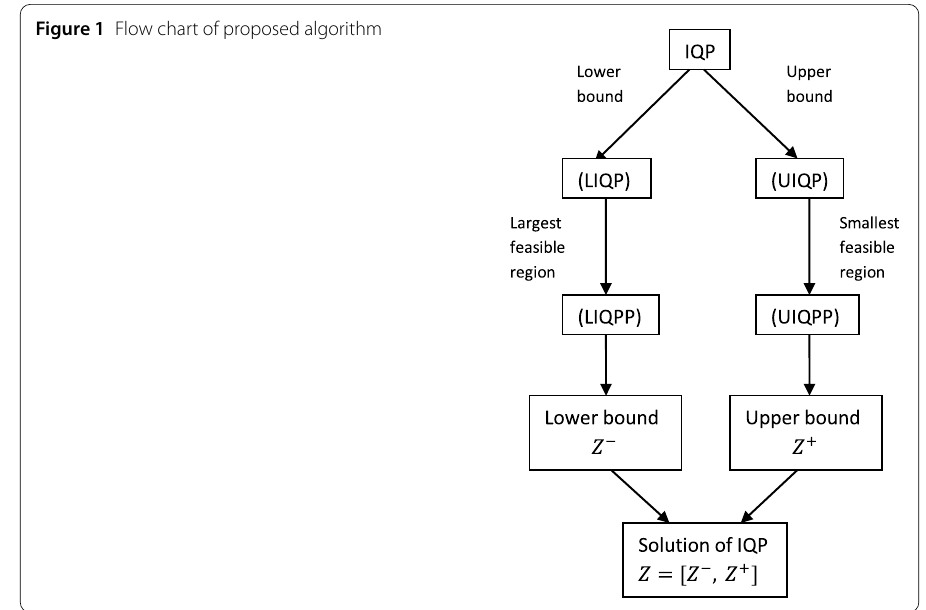
Figure 1 Flow chart of proposed